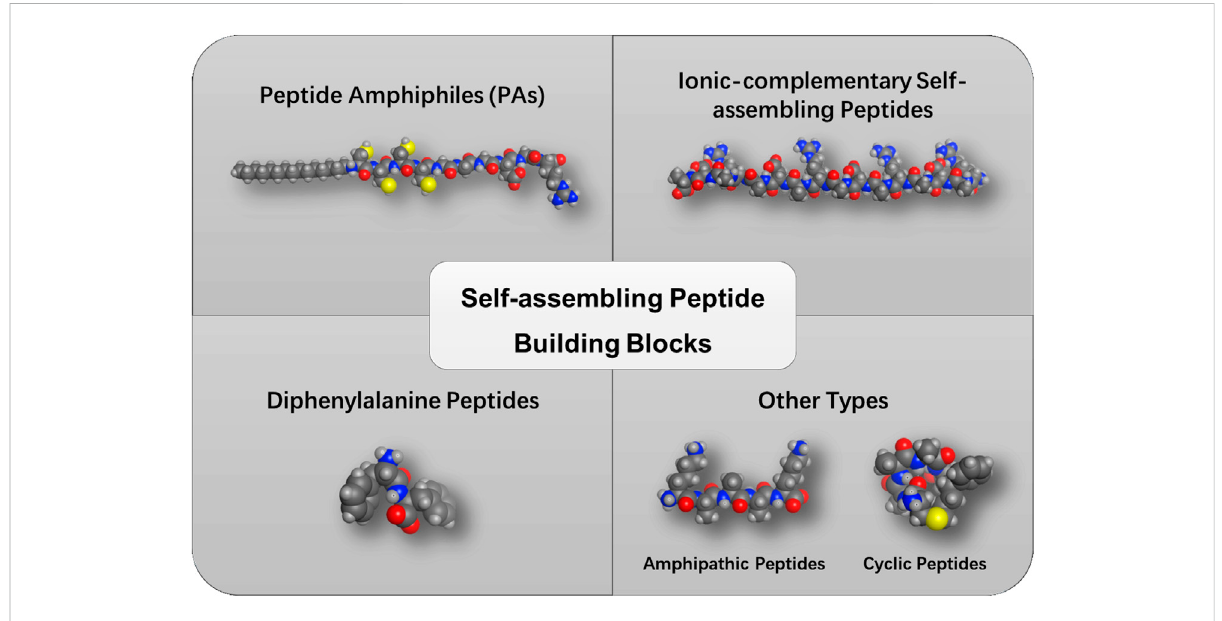
FIGURE 1 Categories of self-assembling peptide building